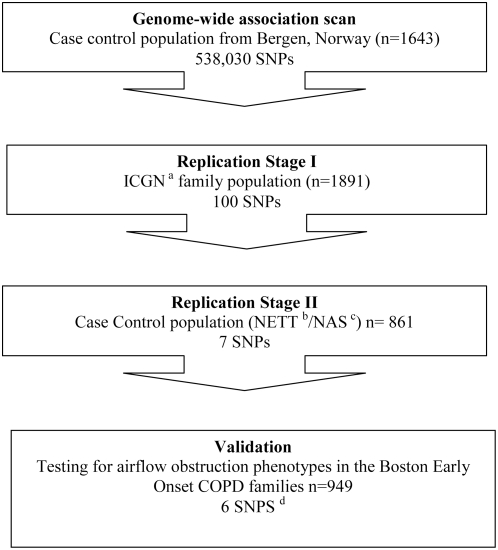
Study design.SNP: Single Nucleotide Polymorphism. aICGN: International COPD Genetics Network families. bNETT: National Emphysema Treatment Trial. cNAS: Normative aging study. d One of the SNPs genotyped in NETT/NAS population (rs735243) was not successfully genotyped in the BEOCOPD population.